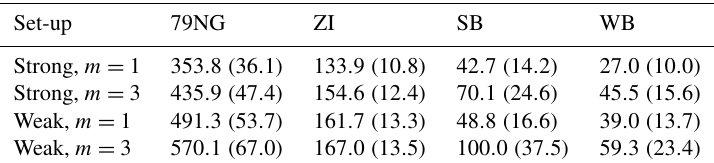
Table 3. Maximum absolute velocity differences ( max ( | (cid:49)v FS − BP-like s | ) , unit is ma − 1 ) and their corresponding relative velocity differences (max ( | (cid:49)v FS − BP-like s | )/v FS s , in brackets, unit is %) for different areas in the outlet domain. Results are listed for l = 150m, P1P1GLS and different set-ups for the basal boundary condition.